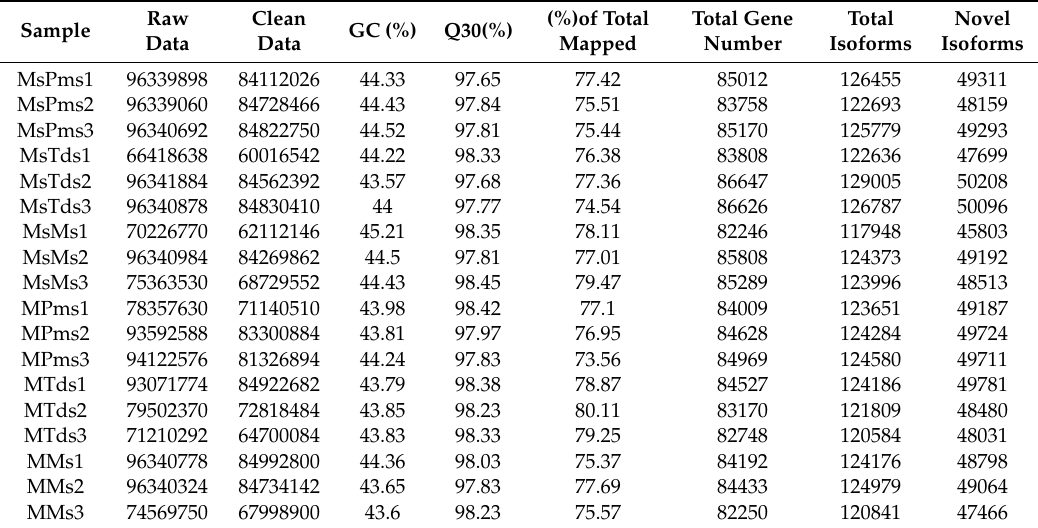
Table 1. Summary of tag